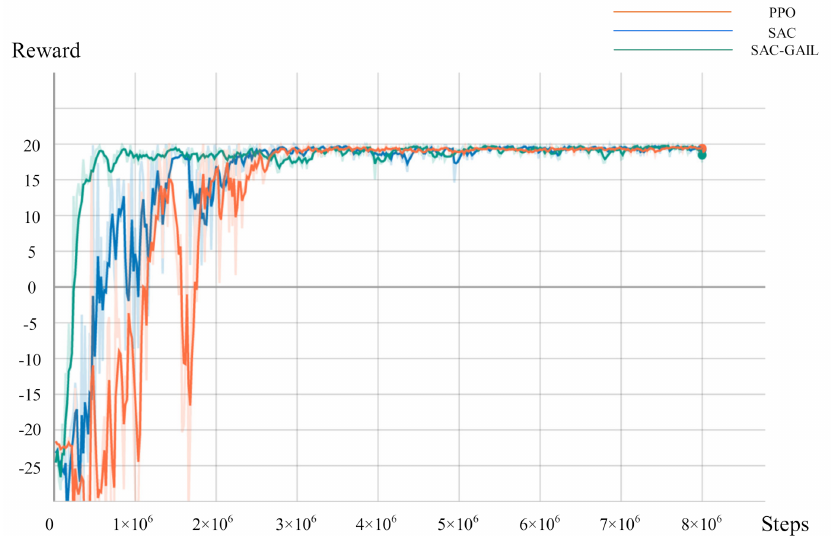
Figure 9. Curve of the reward